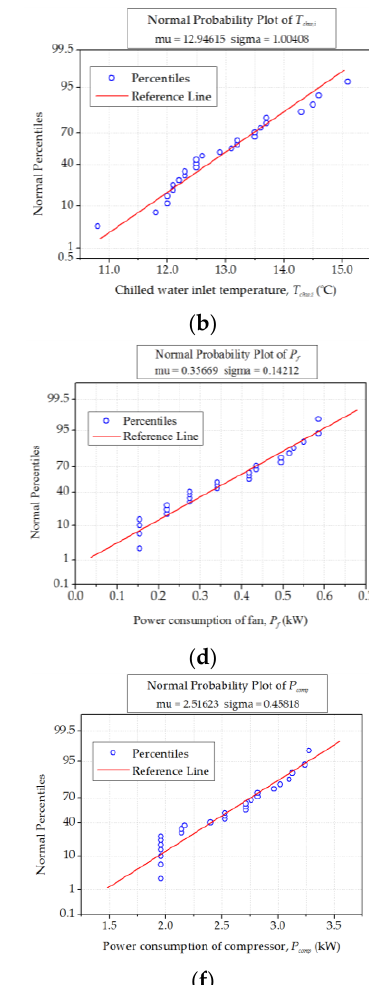
( b ) Figure 5. The predicted COP s, experimental COP s and their uncertainties: ( a ) COP hp , ( b ) COP sys . 5.2. Sensitivity Analysis